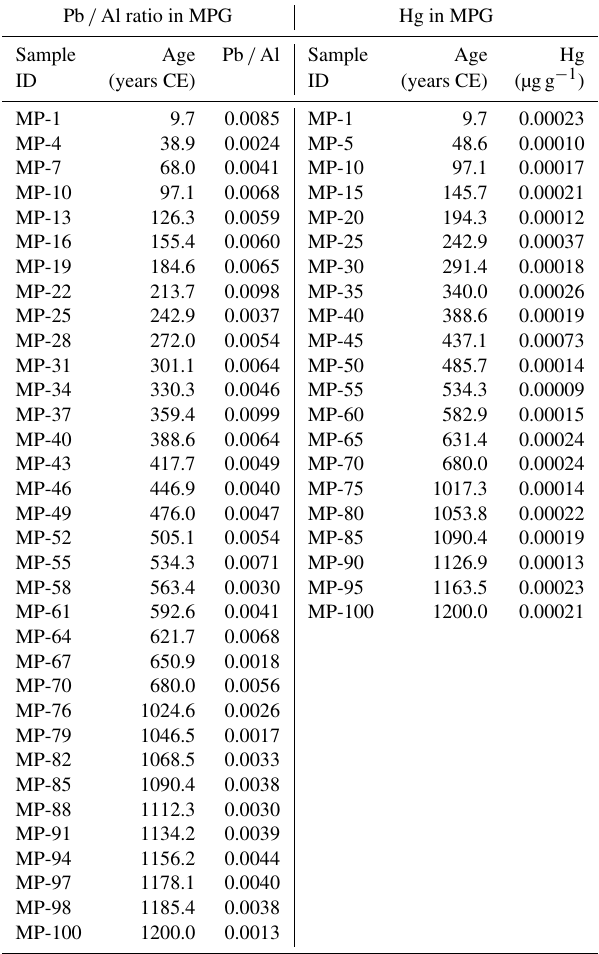
Table 5. Values of Pb / Al ratio and Hg concentration from MPG samples (plotted in Fig.